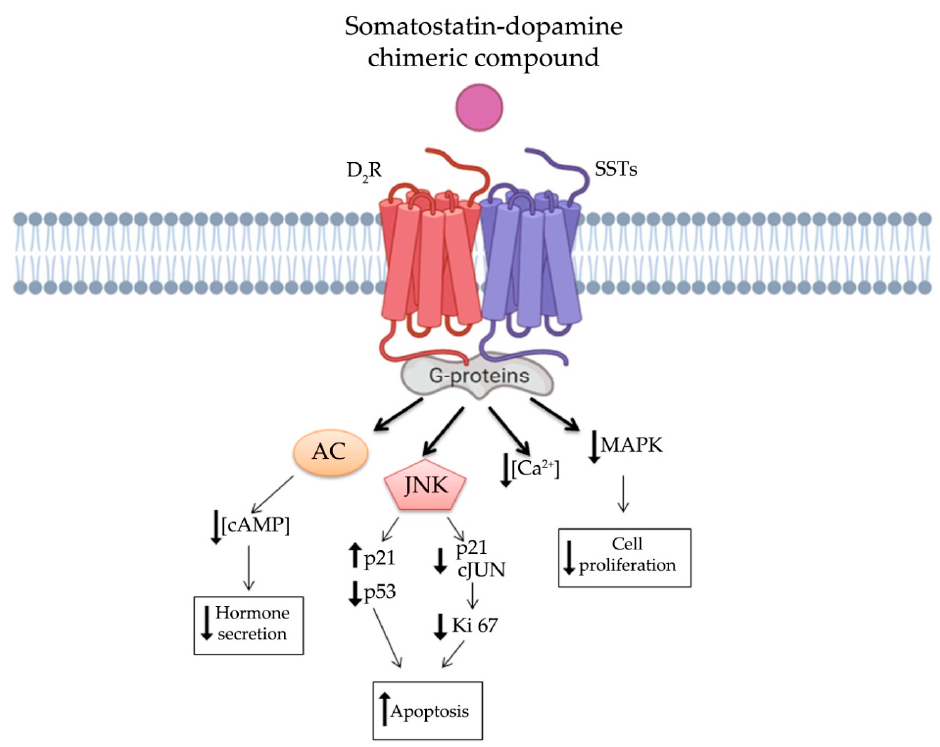
Figure 3. Somatostatin-dopamine chimeric compound induced dimerization of somatostatin and dopamine receptors. Potential intracellular signal pathways linked to receptors heterodimerization and involved in inhibition of hormone secretion, increased apoptosis, and decreased cell proliferation. AC, adenylyl cyclase; cAMP, cyclic adenosine monophosphate; JNK, c-Jun N-terminal kinase and MAPK, mitogen-activated protein kinase.